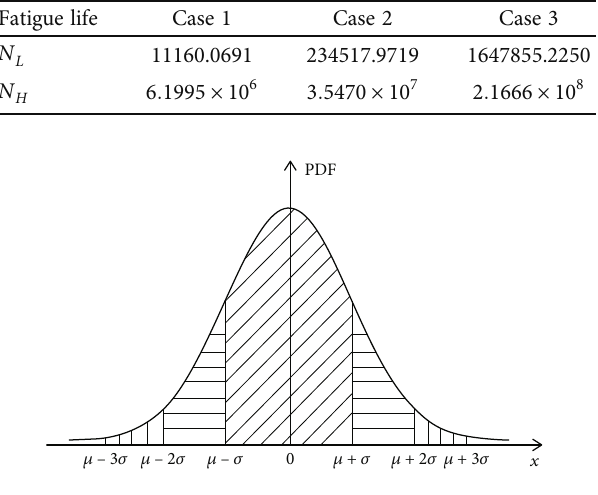
Figure 7: Interval division